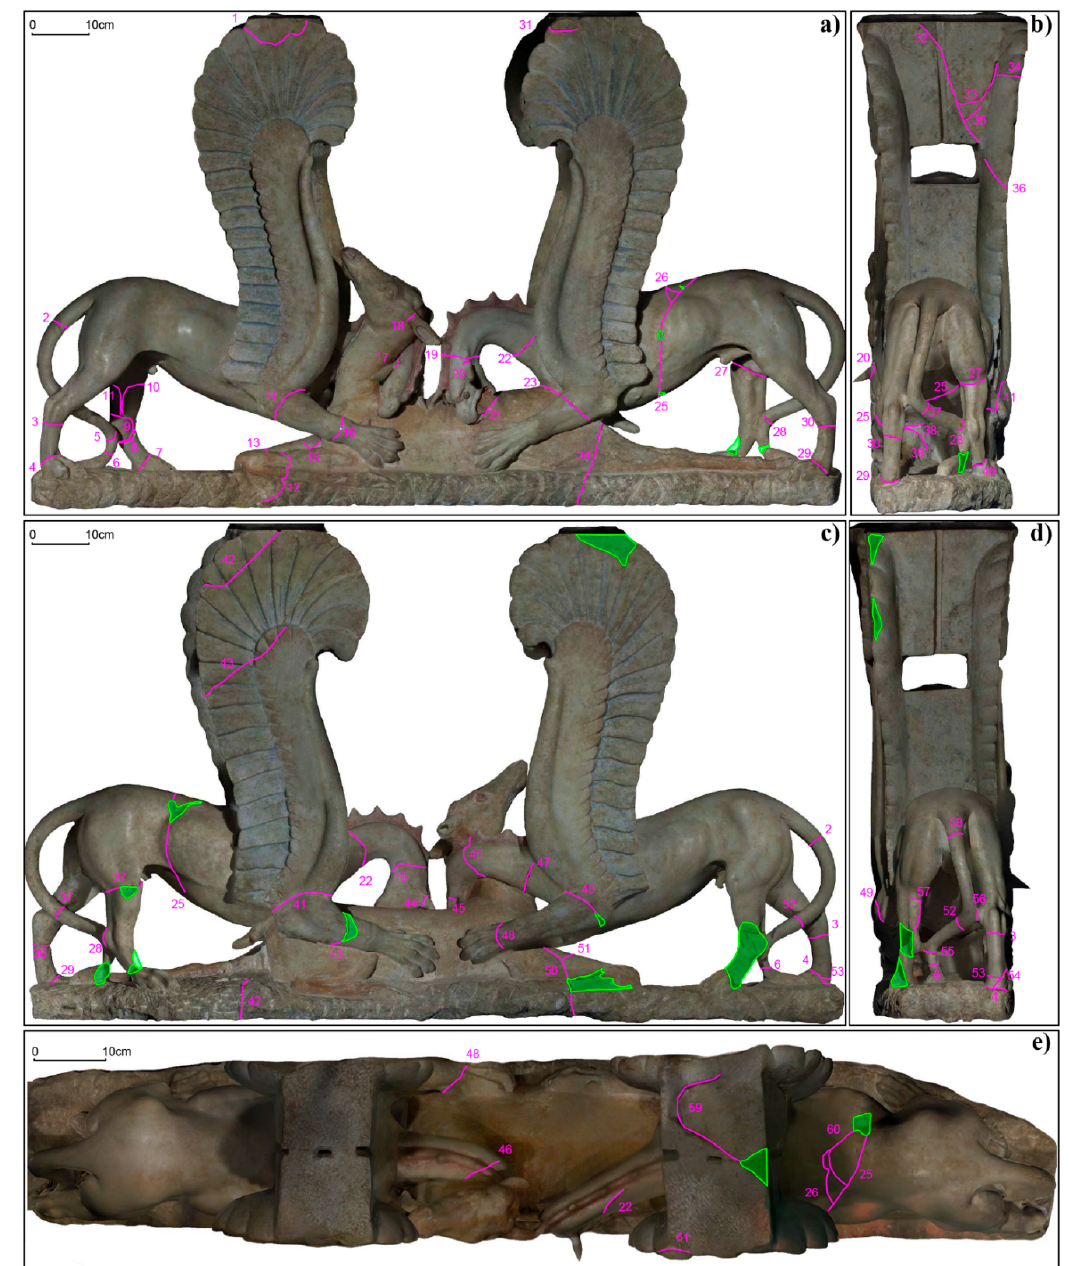
Figure 6. High-resolution orthophoto with indications of cracks: front side ( a ), back side ( b ), right side Figure6. High-resolutionorthophotowithindicationsofcracks: frontside( a ), backside( b ), rightside( c ), ( c ), left side ( d ), and top ( e ). left side ( d ), and top ( e ). Fractures that di ff ered in size, thickness, and orientation could be divided into three